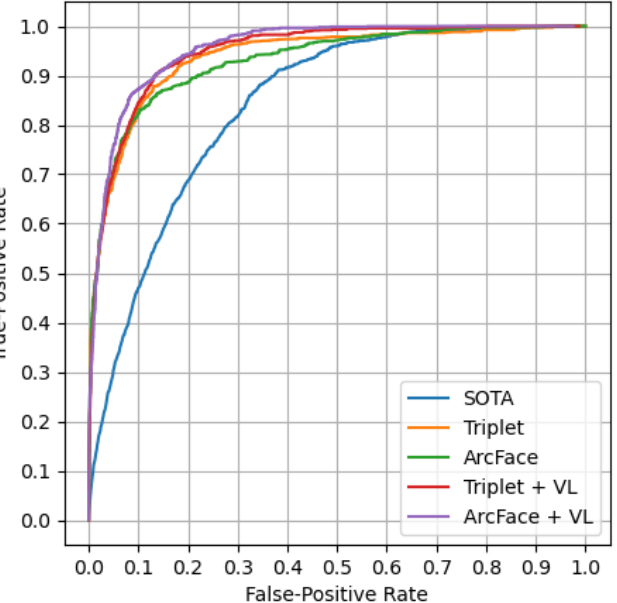
Figure 10. The average receiver operating characteristic (ROC) curves comparing the proposed learning method with the SOTA learning method, the triplet loss learning method and the ArcFace learning method.